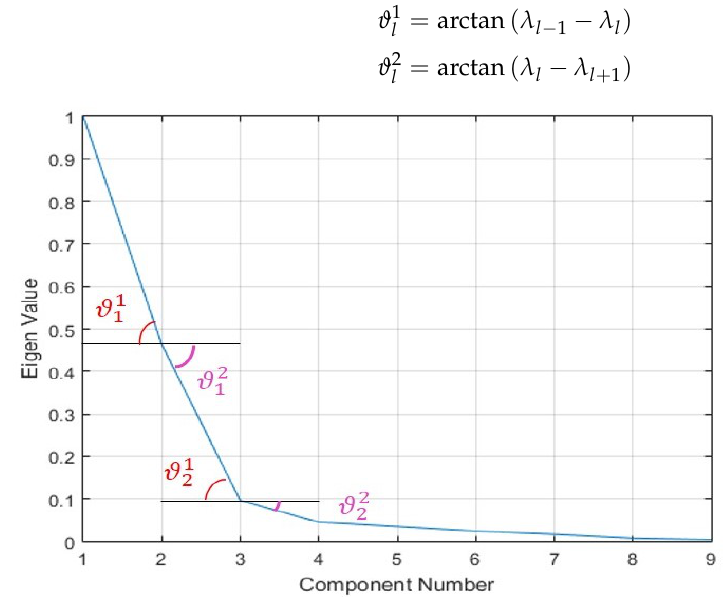
Figure 3. An example of a scree